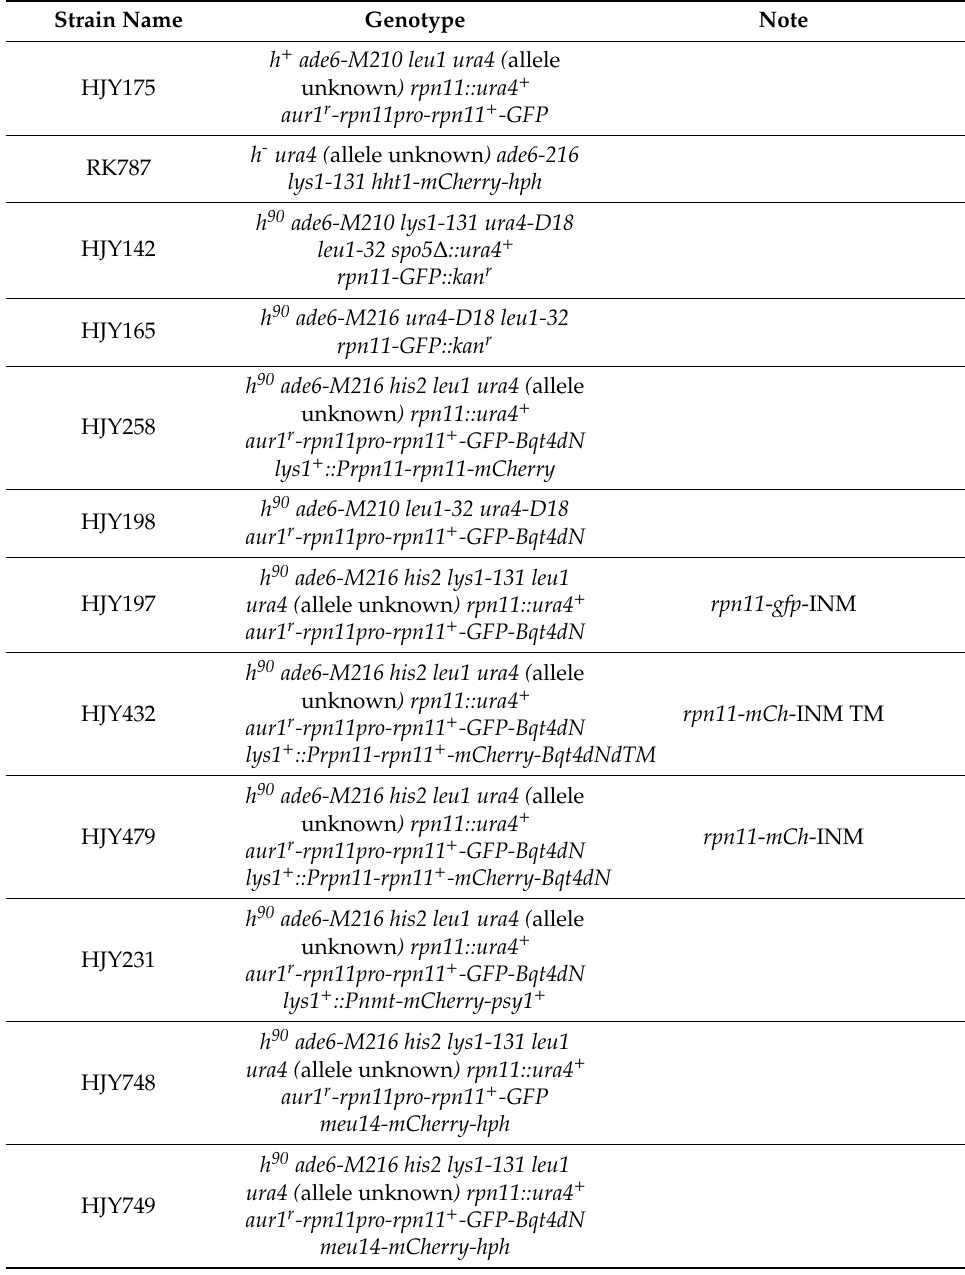
Table 1. S. pombe strain